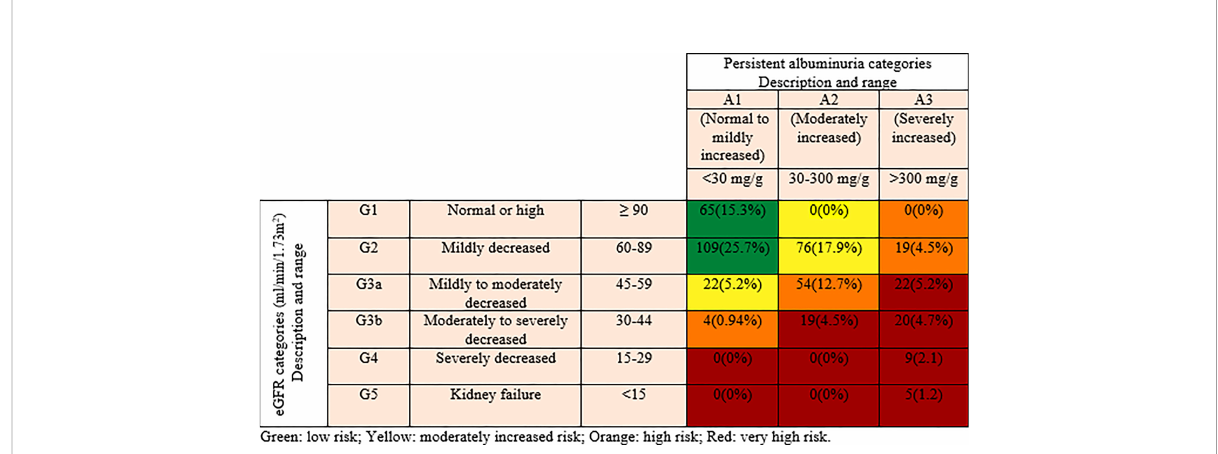
FIGURE 1 Distribution of participants according to the Kidney Disease Improving Global Outcomes (KDIGO) classi fi